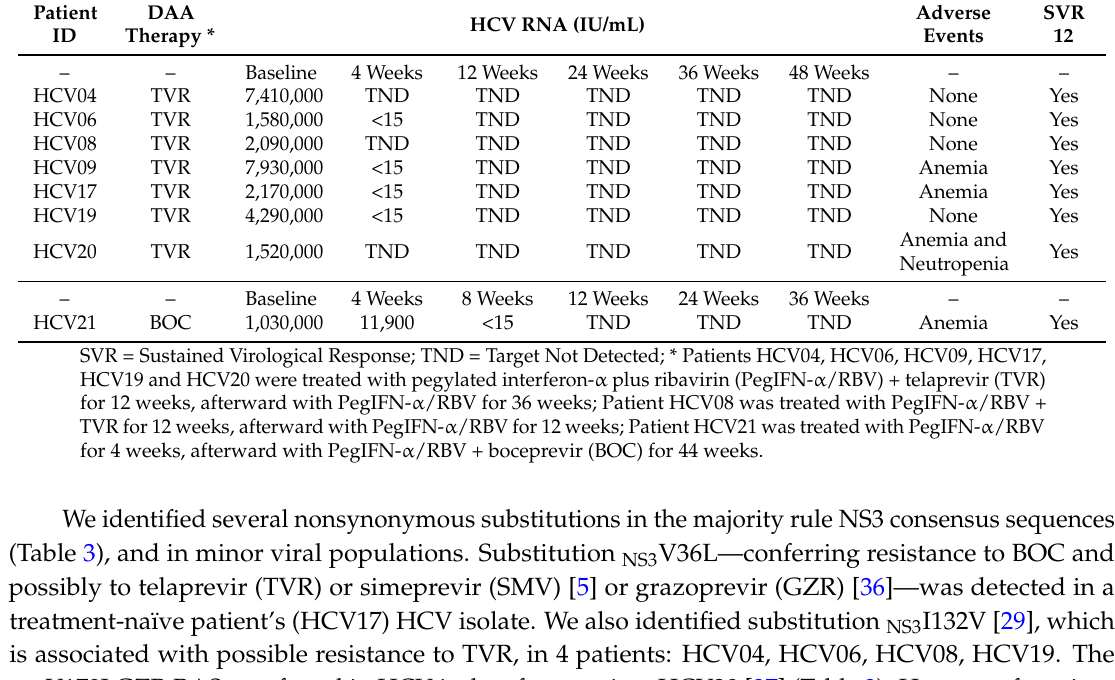
(Table 3), and in minor viral populations. Substitution NS3 V36L—conferring resistance to BOC and possibly to telaprevir (TVR) or simeprevir (SMV) [5] or grazoprevir (GZR) [36]—was detected in a treatment-naïve patient’s (HCV17) HCV isolate. We also identified substitution NS3 I132V [29], which is associated with possible resistance to TVR, in 4 patients: HCV04, HCV06, HCV08, HCV19. The NS3 V170I GZR RAS was found in HCV isolate from patient HCV20 [37] (Table 3). However, for minor substitutions in the NS3 region, nucleotide substitutions were detected at amino acid (AA) positions 55 (10.9%) and 132 (0.05%) in isolates from HCV17 and HCV21 patients, respectively, but these changes did not modify the corresponding AA (i.e., synonymous substitutions). The NS5B C316N mutation associated with resistance to the NS5B polymerase inhibitor, dasabuvir (DSV) [38], was found in two patients (HCV06, HCV19), who also harbored NS3 I132V and NS5B C316N (Table 3).